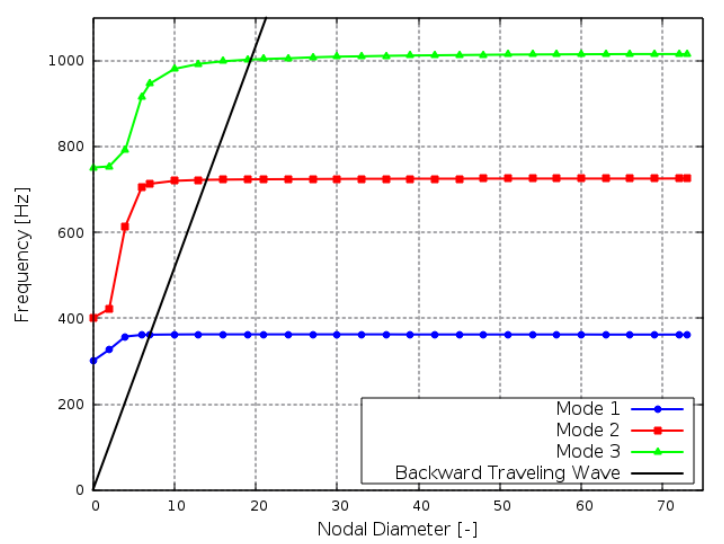
Figure 7. ZZENF diagram with the first three mode shape families.